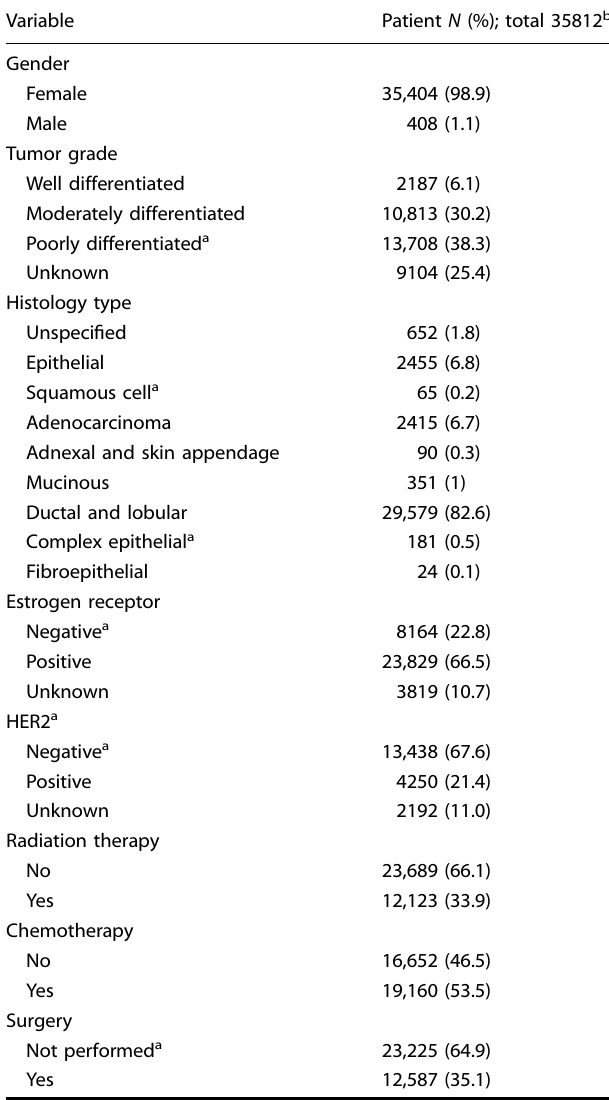
Table 1. Distribution of the population demographics and clinicopathologic factors a